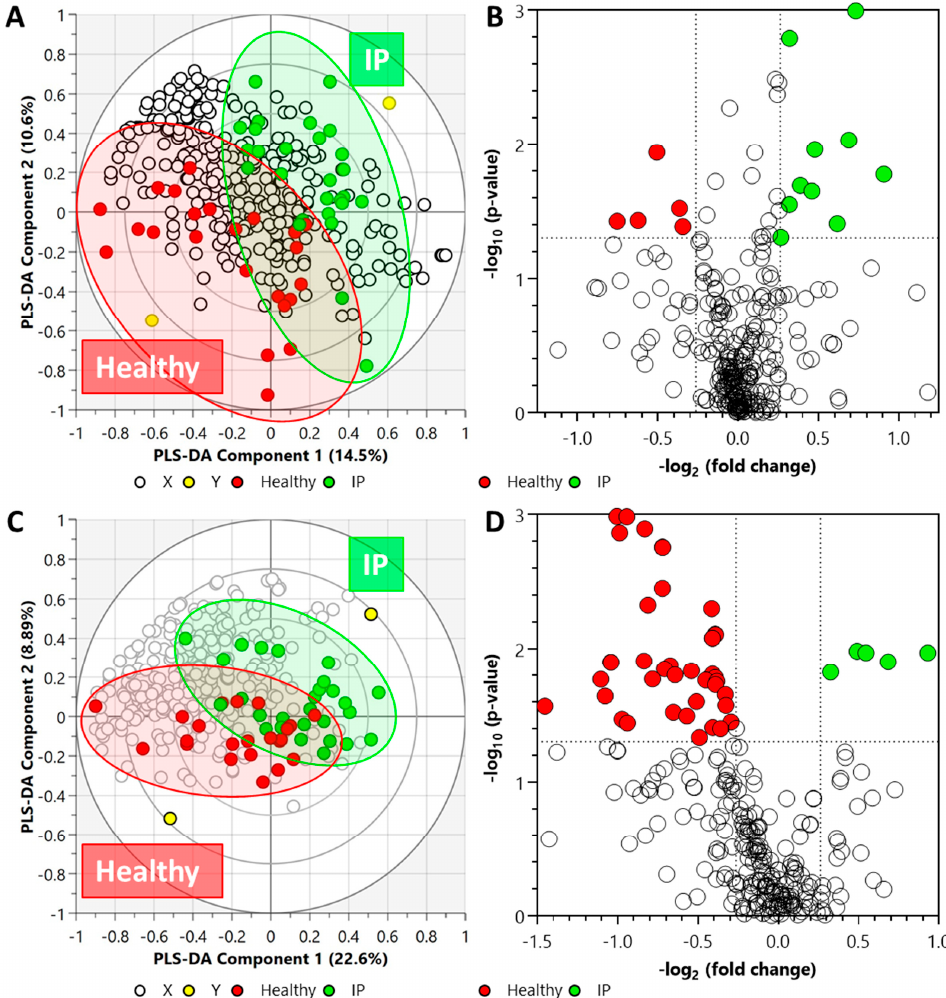
Figure 3. Biplot overview (panels A , C ) of LC-QToF MS acquired data set and associated global view (panels B , D ) of the significant compounds. (Panels A , B ) metabolite data set from plasma samples (R 2 X = 0.358, R 2 Y = 0.934, Q 2 = 0.355), and (panels C , D ) lipid data set from plasma samples (R 2 X = 0.572, R 2 Y = 0.833, and Q 2 = 0.0746). Note: In panels ( A , C ), the ellipses on the biplots represent the 100%, 75%, and 50% correlation coefficient for measured metabolites. The colored circles represent each analyzed sample, while the yellow-colored circles indicate the averaged group position for each sample cluster, and the white circles represent the distribution of LC-QToF MS detected metabolites between increased intestinal permeability (IP) and healthy groups. The colored circles in panel ( D ) represent significant metabolites in IP subjects compared with the healthy subjects .